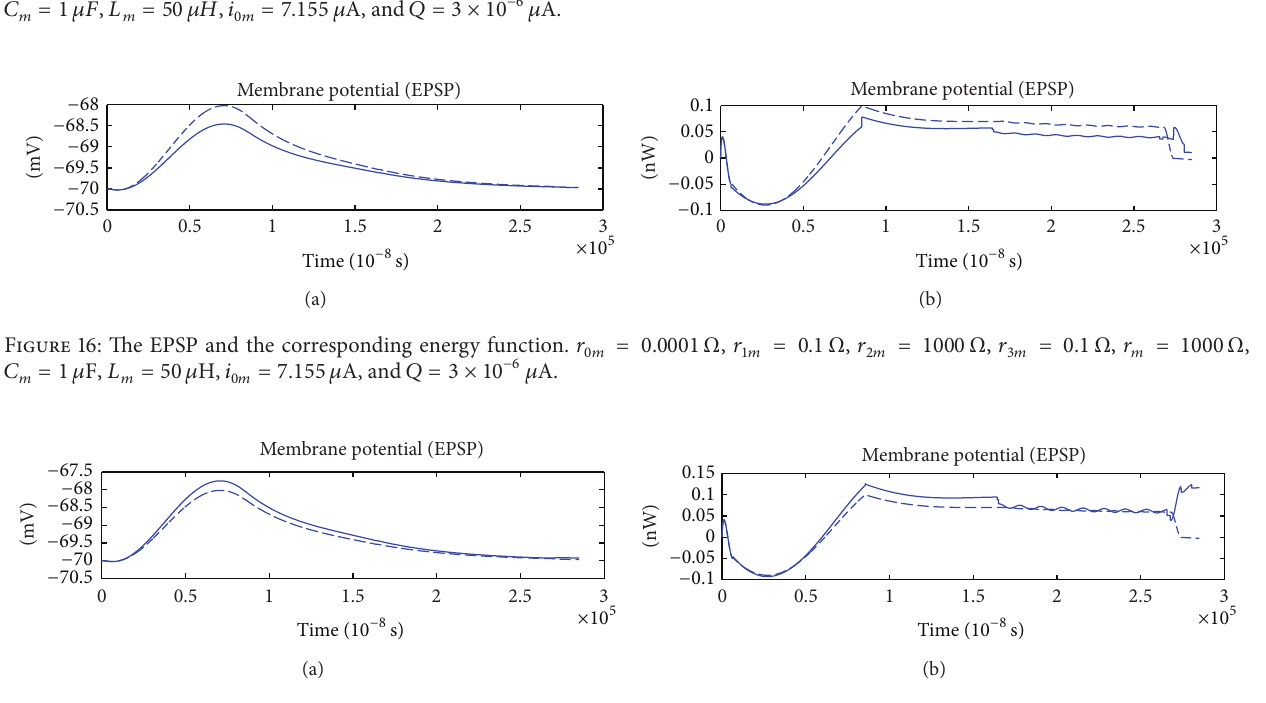
Figure 17: The EPSP and the corresponding energy function. 𝑟 0𝑚 = 0.0001 Ω , 𝑟 1𝑚 = 0.1 Ω , 𝑟 2𝑚 = 1000 Ω , 𝑟 3𝑚 = 0.1 Ω , 𝑟 𝑚 = 1000 Ω , = 1 𝜇 F, 𝐿 = 50 𝜇 H, 𝑖 = 7.155 𝜇 A, and 𝑄 = 3 × 10 −6 𝜇 A. 𝐶 𝑚 𝑚 0𝑚